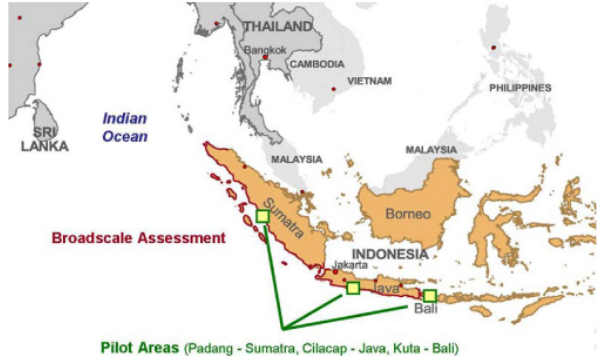
Fig. 1. Areas of tsunami risk assessment: broad-scale analysis for the coastal regions (depicted in red) and detailed analysis in the three pilot areas Padang, Cilacap and Kuta (depicted in